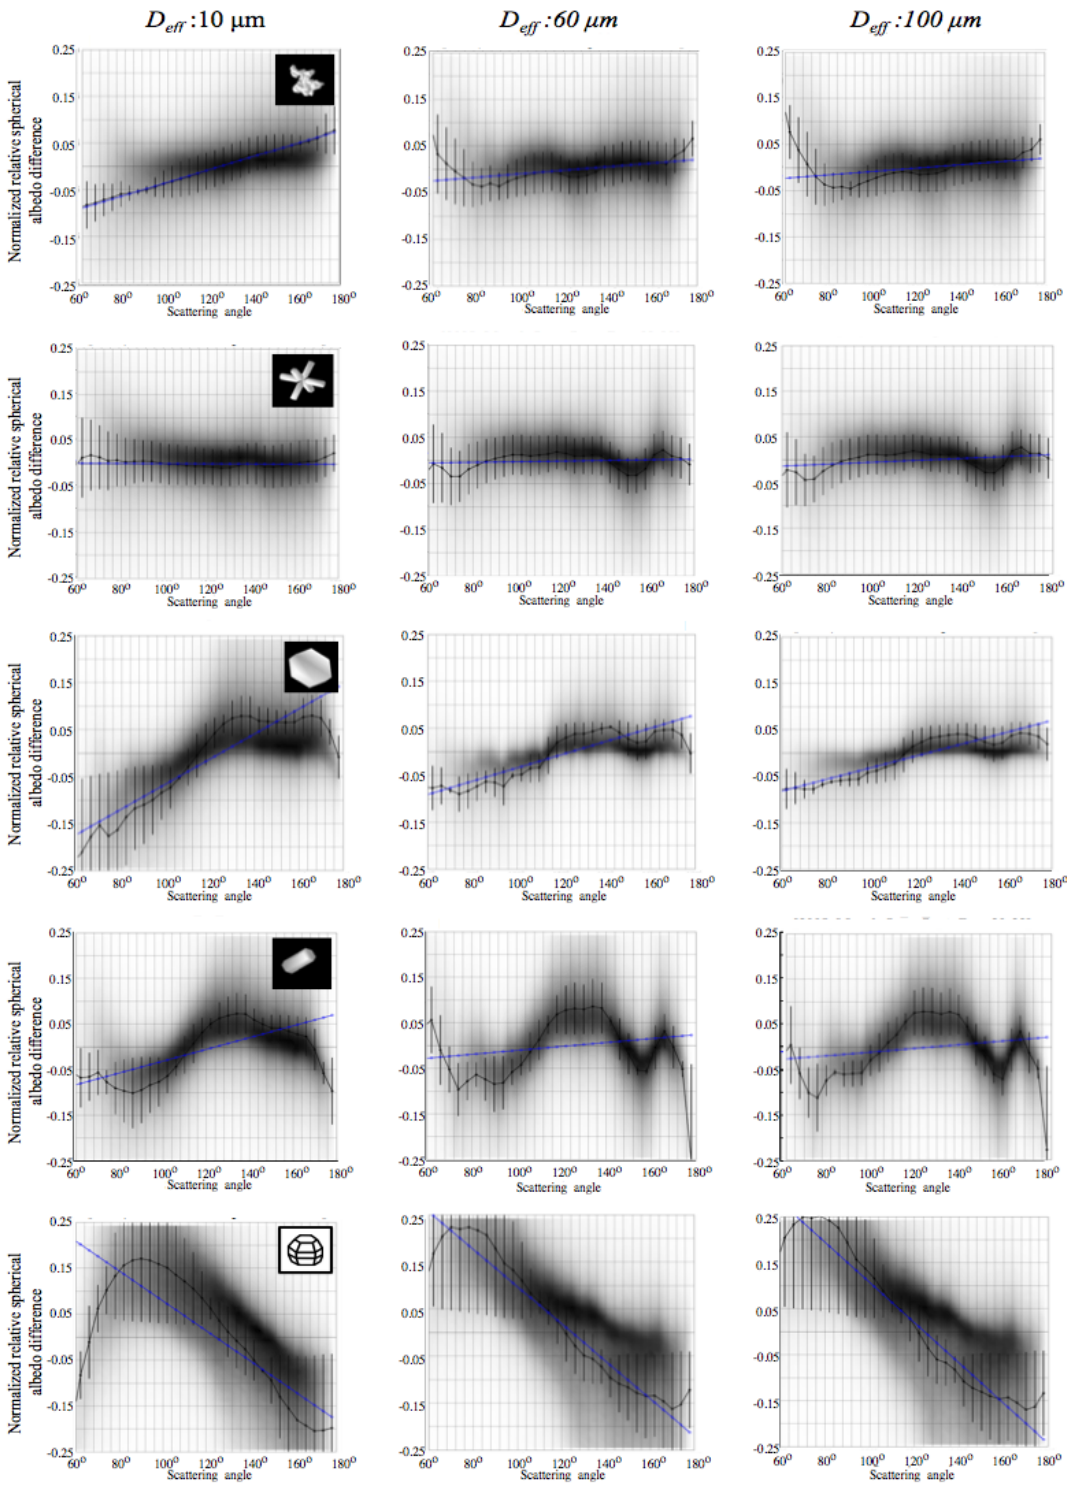
Figure 6. SAD analysis as a function of different particle habits and effective diameters ( D eff ) using POLDER measurement. Black contours show the density of the observations normalised to the maximum value, and the blue line shows the regression